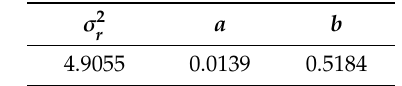
Table 2. The estimation result of the prior parameter Θ .